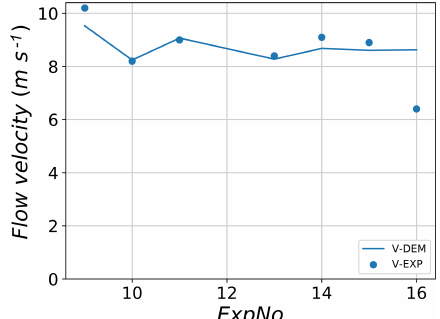
Figure 16. Flow front velocity, measured between sections 1 and 2, for experimental data and their corresponding best-fit DEM simula-